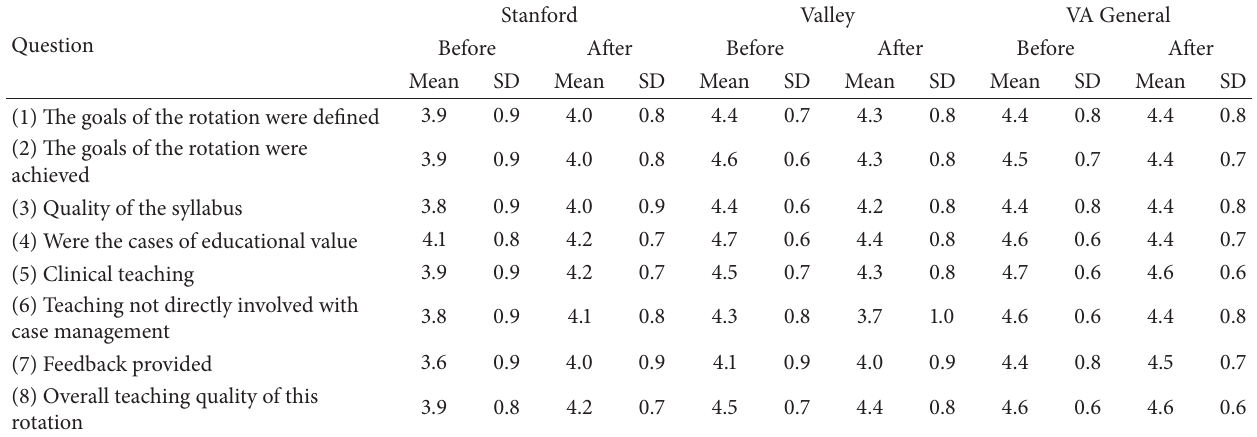
Table 1: Descriptive summary scores by hospital.